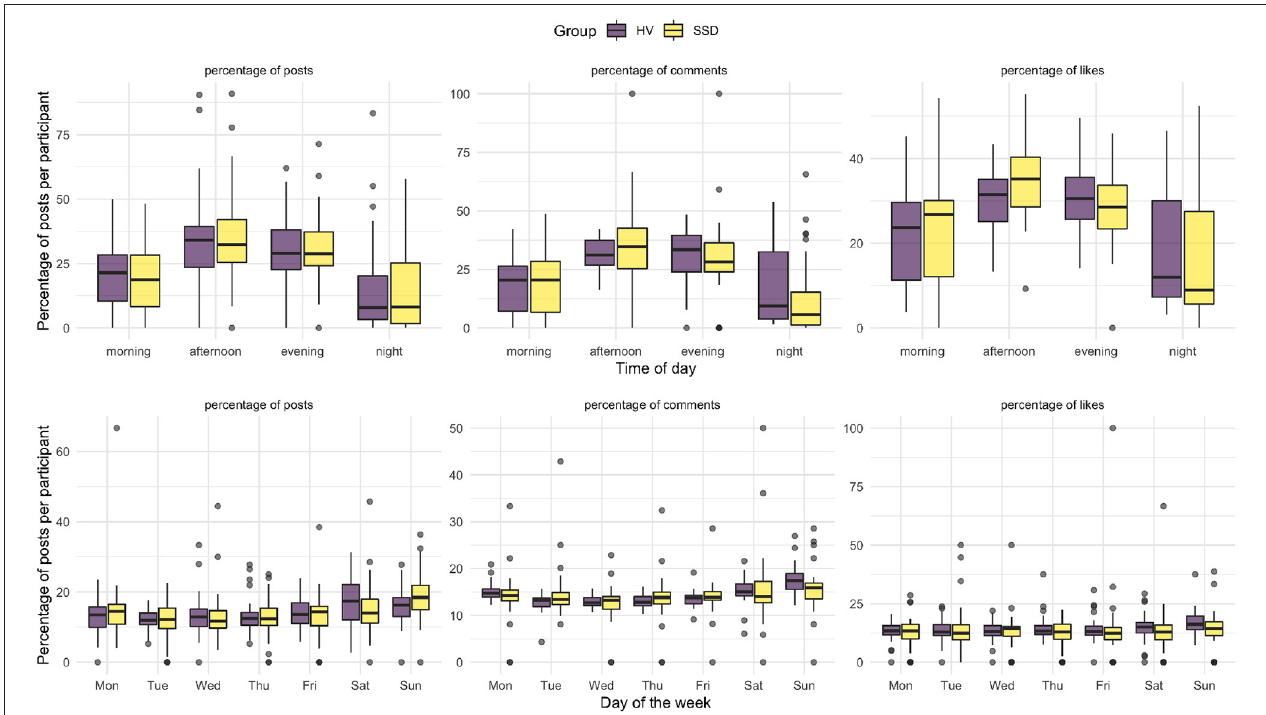
FIGURE 3 | Temporal aspects of posting behavior. The graphics illustrate an overview of the percentage of actions (i.e., posting content, liking other user’s content, commenting on other user’s content) per participant that have been performed in each of these temporal categories. Top plot: Posting behavior throughout the day: The data was binned into morning (6 a.m.–12 p.m.), afternoon (12 p.m.–6 p.m.), evening (6 p.m.–12 a.m.) and night (12 a.m.–6 a.m.) in accordance with Feuston and Piper (50). Bottom plot: The plot shows the percentage of posts during the days of the